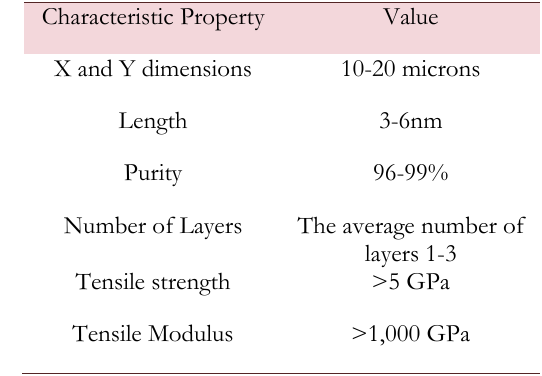
Table 1: Properties of Graphene nanosheets.